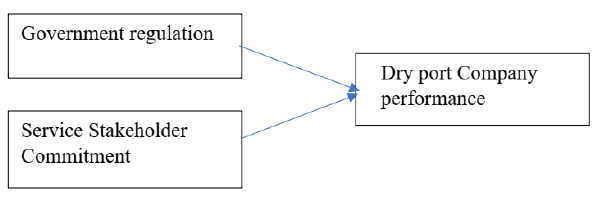
Fig. 1. Research framework